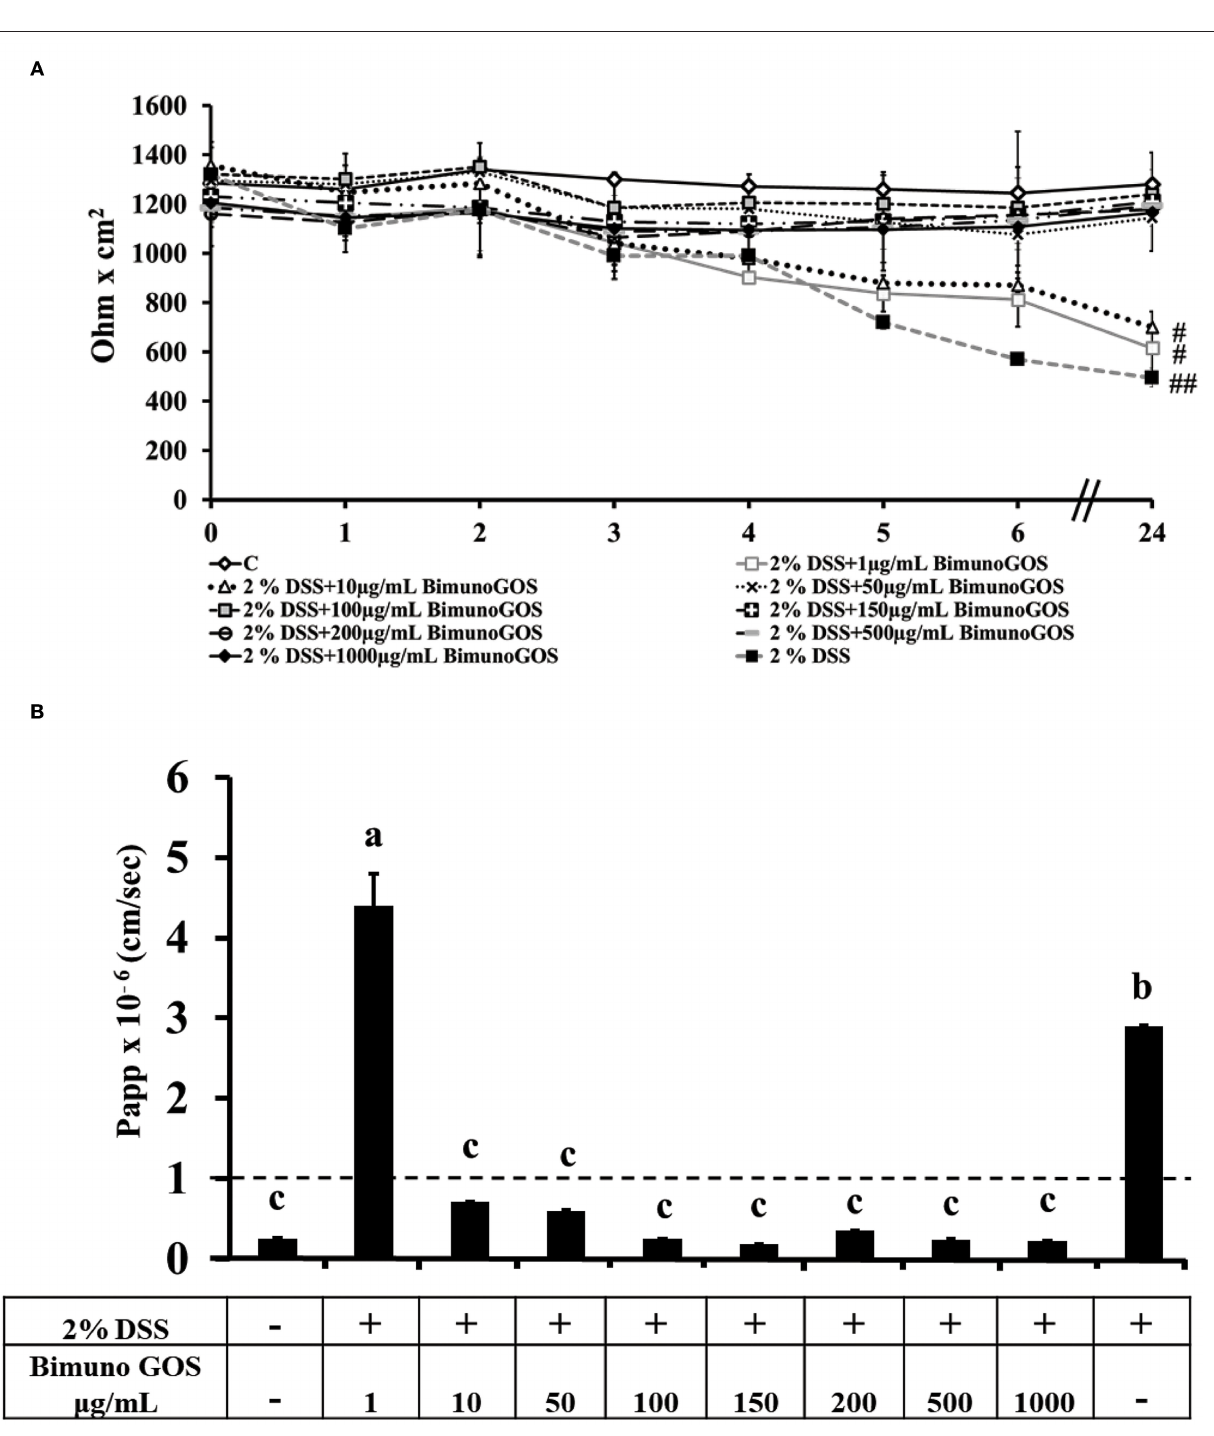
Frontiers in Nutrition | www.frontiersin.org